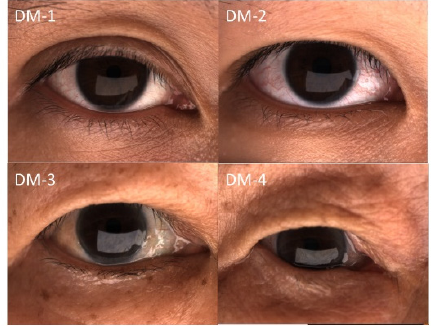
Figure 1. Representative external eye photograph of eyelid configuration.